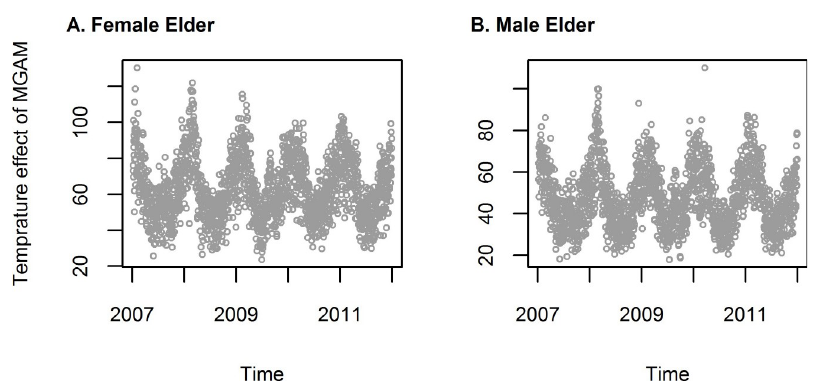
Fig 2. Seasonal pattern of temperature after proper selection of degree of freedom of natural spline (df t = 5).